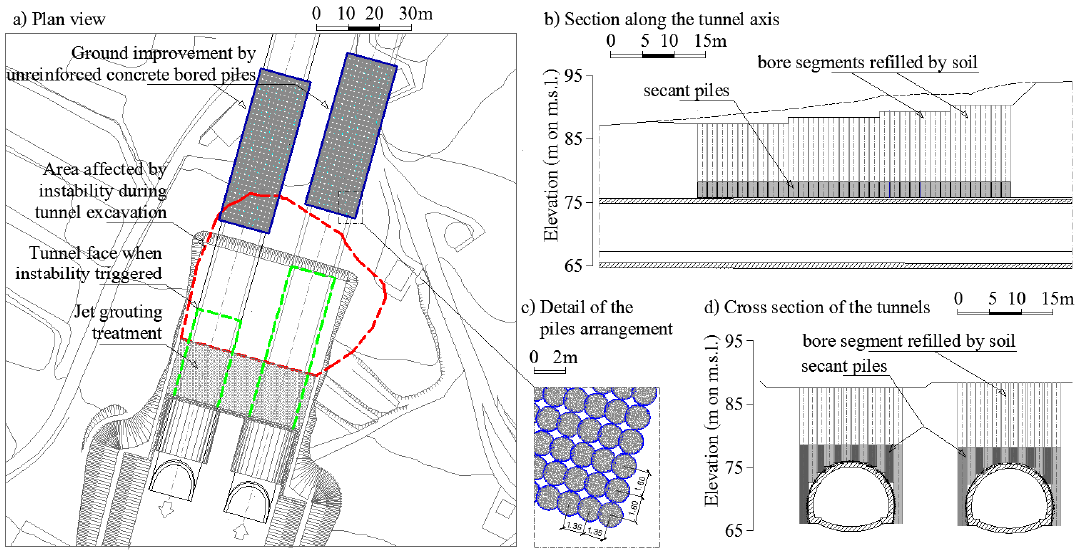
Figure 12. ( a ) Plan view of the Trigoni tunnel close to the southern entrance; ( b ) Section along the axis of a tunnel with the arrangement of concrete columns; ( c ) Detail of the pile arrangement; ( d ) Cross-section of the tunnels with the arrangement of concrete columns